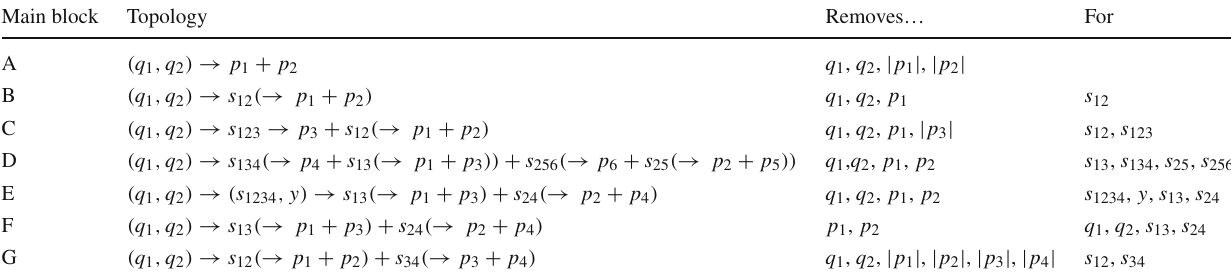
Table1 SetofMoMEMtaMainBlocks.Eachblockperformsaspecific changeofintegrationvariables,andremovesfourdegreesoffreedomby enforcing momentum conservation between the initial and final states. Thethirdandfourthcolumnsshowtheintegrationvariablesrespectively removed and introduced in each block definition. Block G is introduced in this work, in addition to those originally defined in MadWeight . We denote by q i the Bjorken fractions of the initial-state partons, and by p i the 4-momentum of a final-state particle, parameterised in polar coordinates by | p i | , θ i and φ i . An off-shell particle decaying to a set of